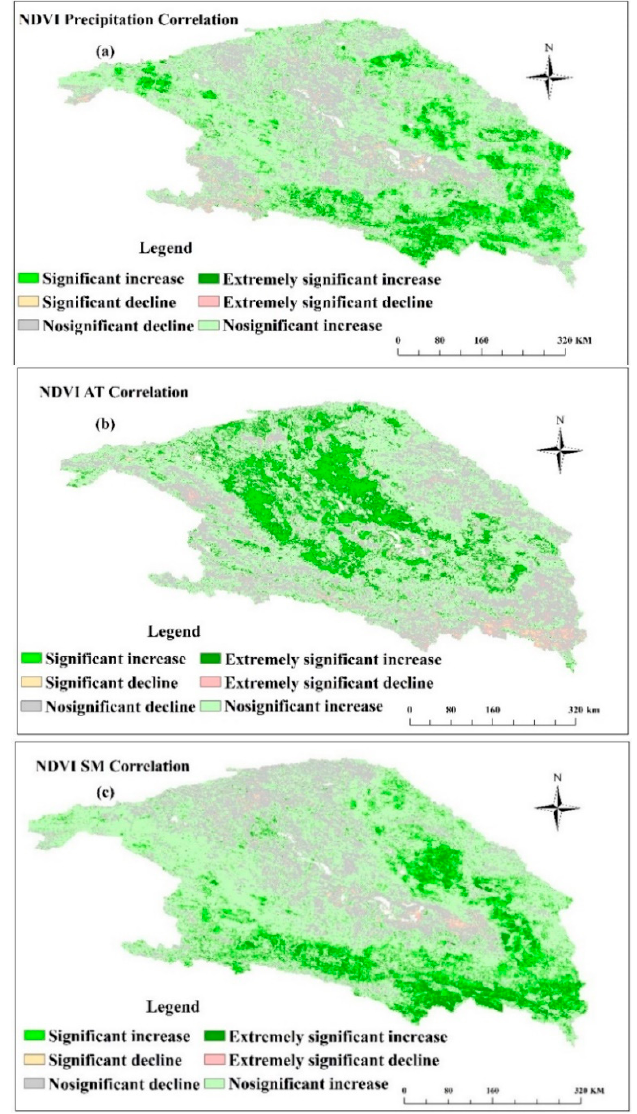
Figure 8. Spatial pattern of NDVI and precipitation ( a ), accumulative temperature (AT) ( b ) and soil moisture (SM) ( c ) correlation significance.